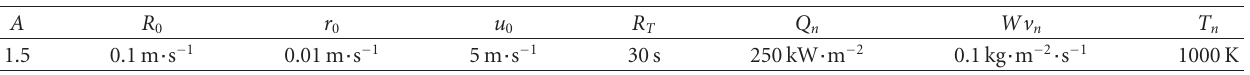
Table 1: Experimental parameters, with A : Radiant factor, R 0 : rate of spread without wind and slope, r 0 flame thickness speed factor, u 0